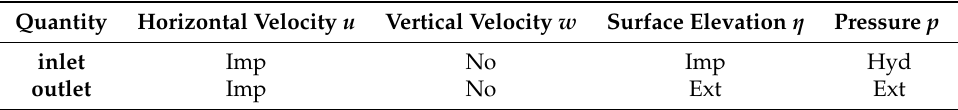
Table 1. Imposed and extrapolated quantities for inlet and outlet buffer particles (Imp = imposed, Ext = extrapolated, Hyd =